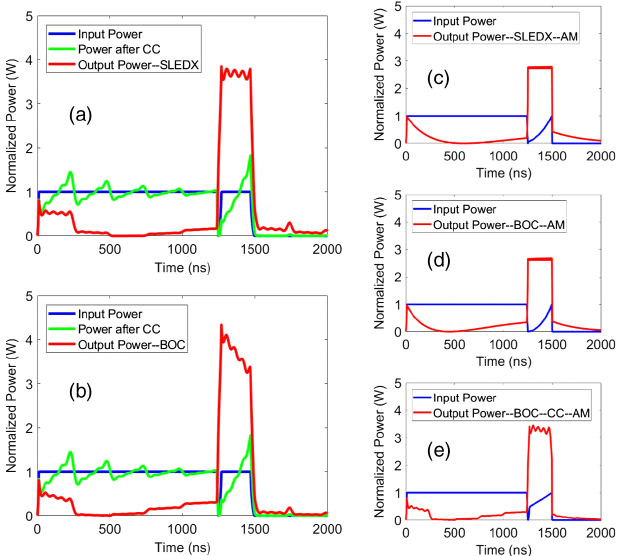
FIG. 2. (a): The corrected waveforms of the SLEDX ( Q 0 ¼ 177 000 , β ¼ 5 . 98 ). (b): The corrected waveforms of the BOC ( Q 0 ¼ 158 000 , β ¼ 7 ).(c): Theamplitude-modulated(AM)wave- forms of the SLEDX. (d) The AM waveforms of the BOC. (e) The AM waveforms of the BOC-CC system. All the waveforms are simulated based on theoretical